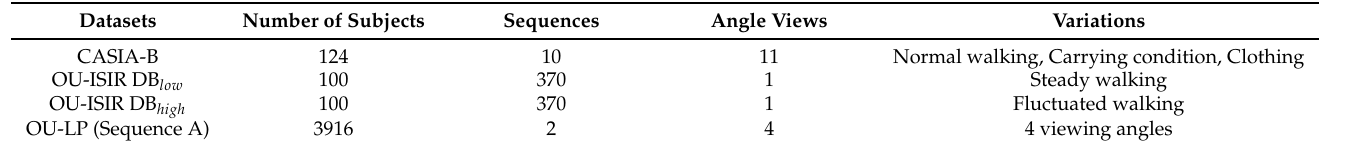
Table 1. Summary of